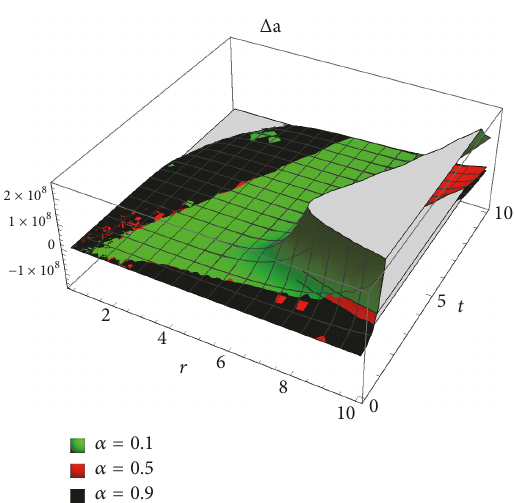
Figure 11: Anisotropy parameter behavior for 𝑟 0 = 0.5 and the different values of 𝛼 .